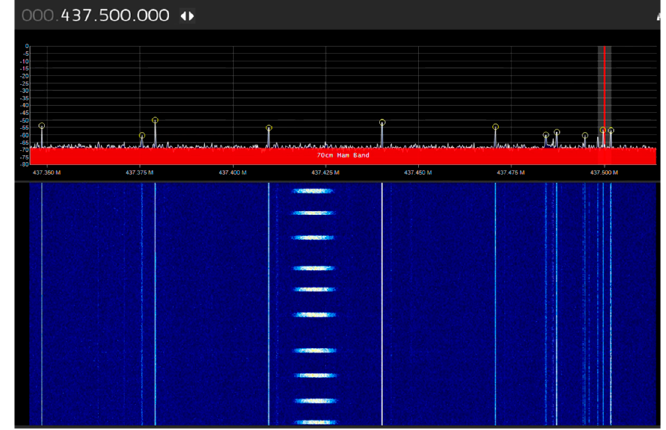
Figure 17. FSK signal received on the ground.